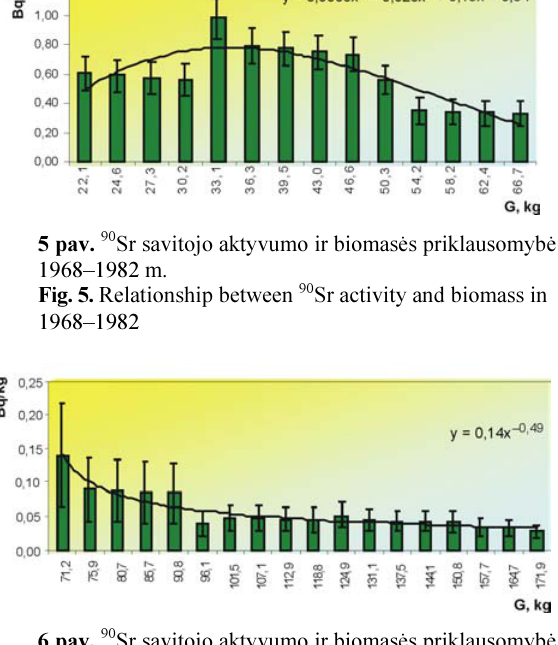
90 Sr activity and biomass